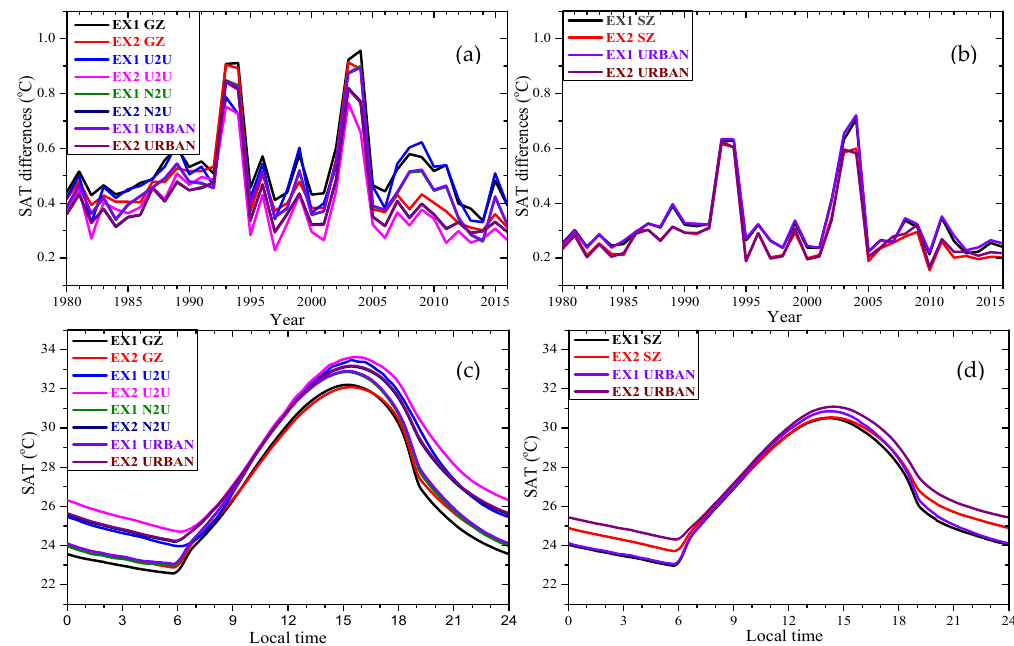
Figure 8. Time series of differences in annual mean SAT under EX1 and EX2 over the subregions of ( a ) Guangzhou and ( b ) Shenzhen between T 4 and T xn (T xn minus T 4 ).